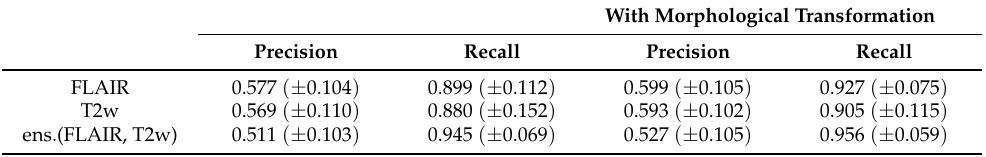
Table 2. Detection results on TCGA-GBM test with 97 test patients. Results present the mean ± standard